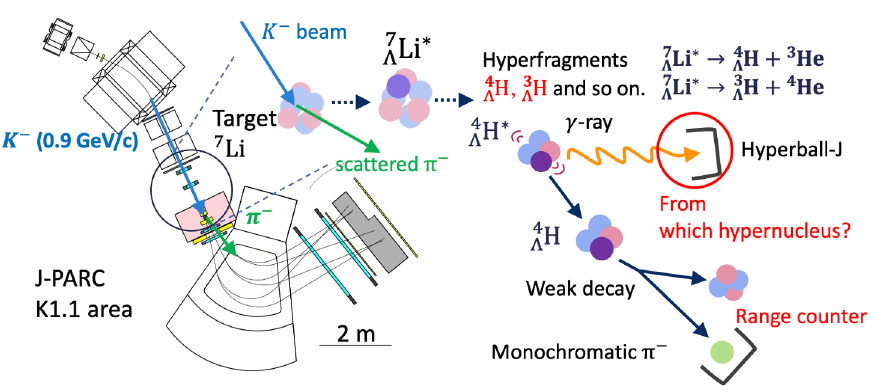
Figure 2. (Left) Experimental setup. The ( K − , π − ) reaction is identified using upstream or downstream spectorometers. (Right) The gamma-weak coincidence of 4 Λ H using a range